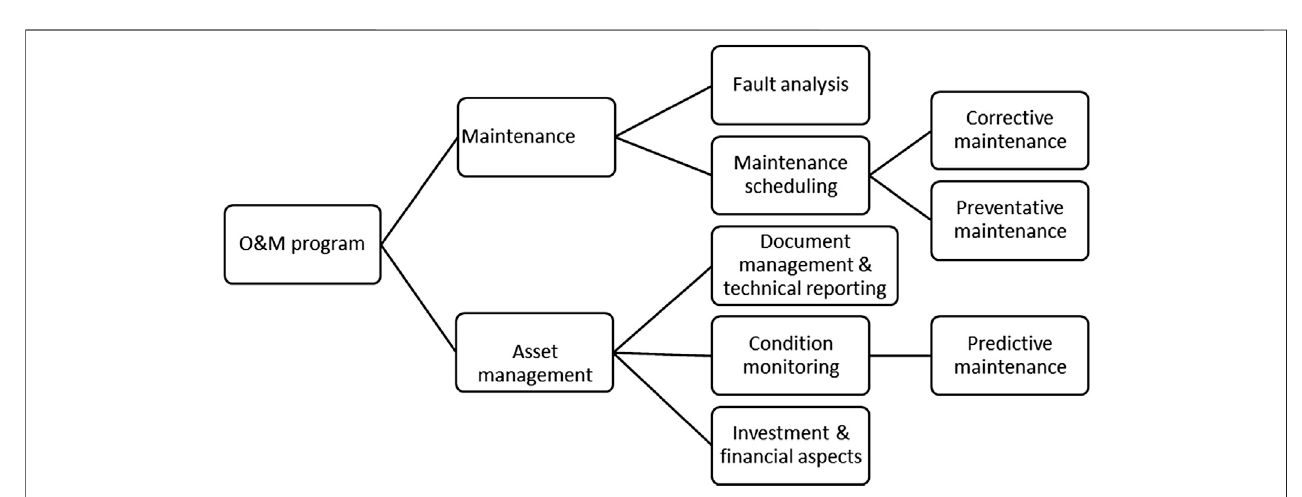
FIGURE 6 | Schematic for the main aspects of a maintenance program (Eltawil and Zhao 2010; Hirsch et al., 2018).